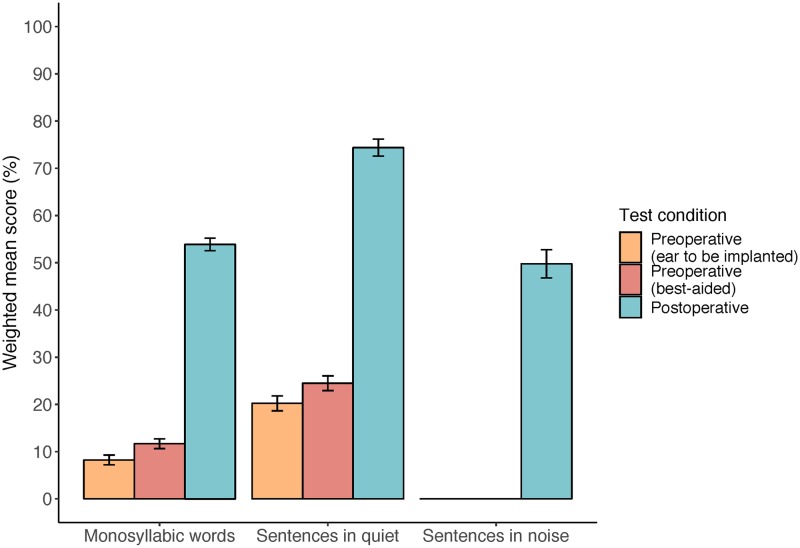
Postoperative speech perception performance in the CI ear alone compared with pre-operative performance for three outcome measures.Error bars represent the 95% confidence interval.